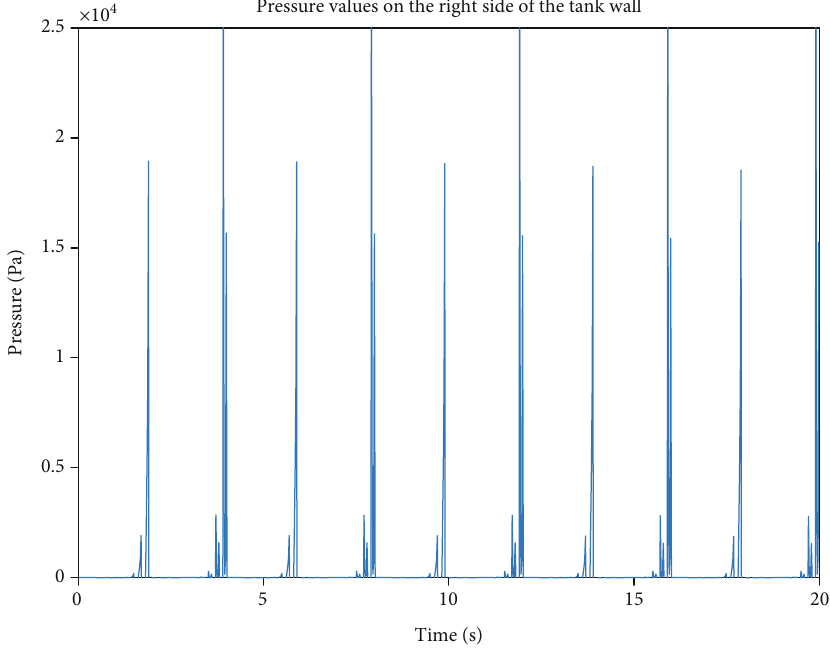
Figure 4: Variation in pressure acting on the tank wall for h = 0 : 28 .